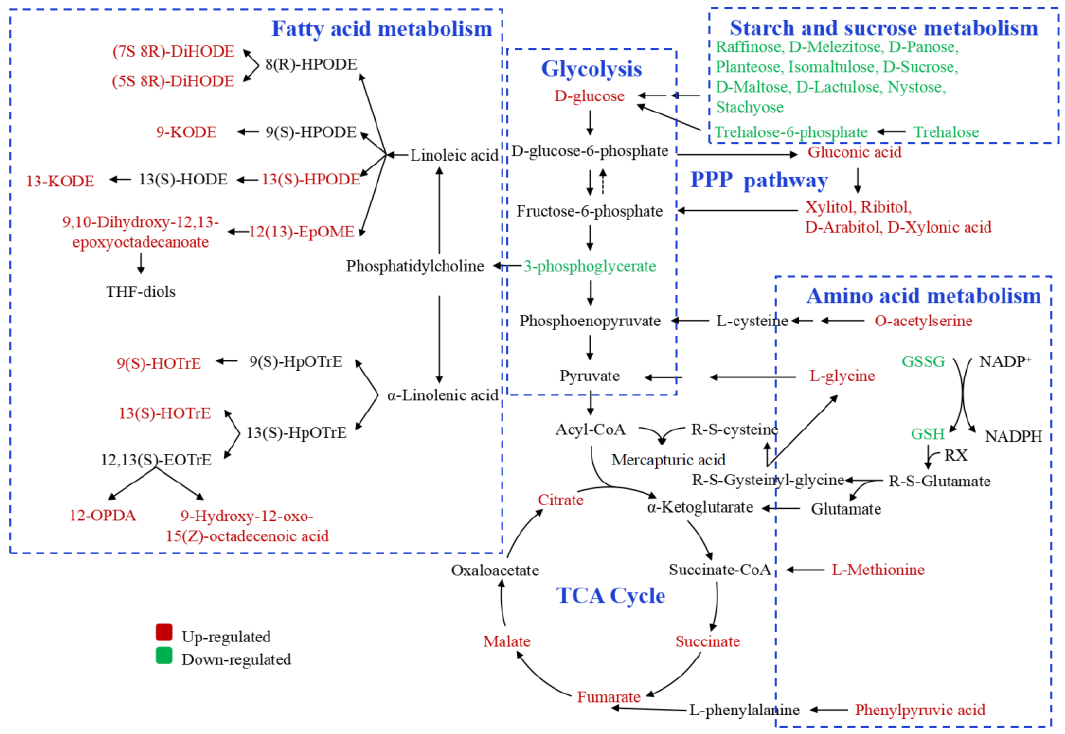
Figure 8. Changes in metabolites mapped to the metabolic pathways of